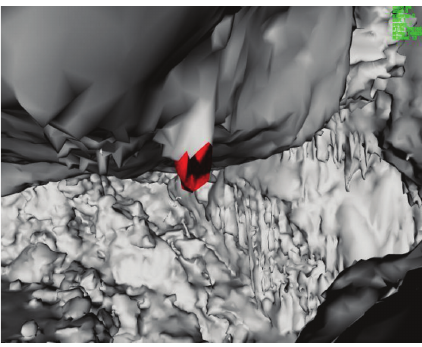
Figure 4: Stalactite selected interactively by the user in the Web3D browser.